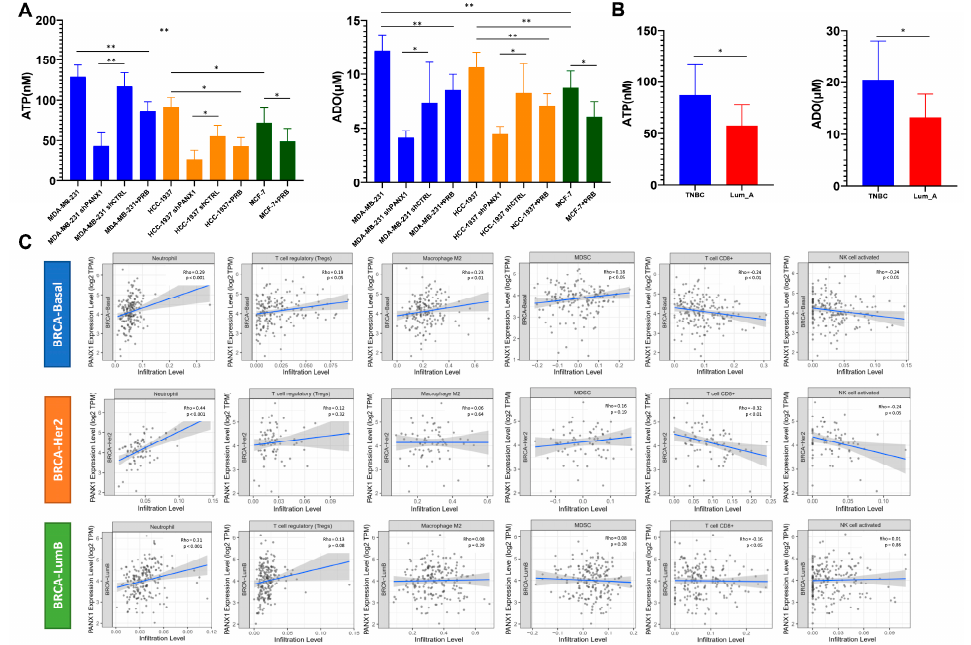
Figure 5. ( A ) Levels of exATP and exADO in MDA-MB-231, HCC-1937 and MCF-7 cell culture media; PANX1 knock down and probenecid (PRB) treatment reduced the levels of exATP and exADO in the supernatant of MDA-MB-231 and HCC-1937 cells (n = 19 for each group; p < 0.05; Student’s t test); ( B ) levels of exATP and exADO in the supernatant of digested tissue from triple-negative and Luminal A breast cancer surgical specimens ( p < 0.05; n = 9 for each group; Student’s t test); ( C ) the correlation between PANX1 expression and infiltration levels of neutrophils, Tregs, M2-like macrophages, MDSC cells, CD8 + T cells, and NK cells in the tumor microenvironment for Luminal B, HER2 enriched and basal-like breast cancer by TIMER (TCGA-BRCA data; Spearman’s rank correlation). (* p < 0.05; ** p < 0.01).